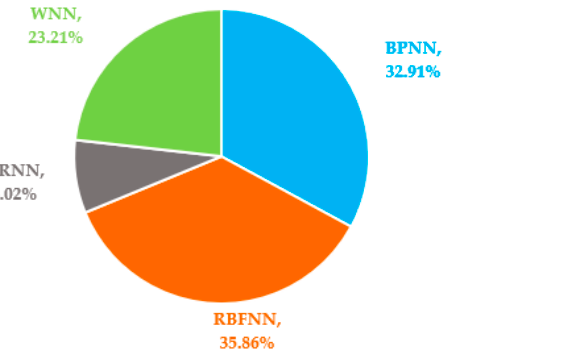
Figure 3. Percentage of 4 different ANNs’ publications in the oil and gas industry (2001–2020).